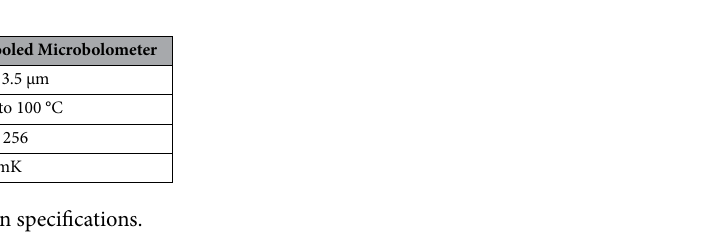
Table 1. FLIR Tau 336 main